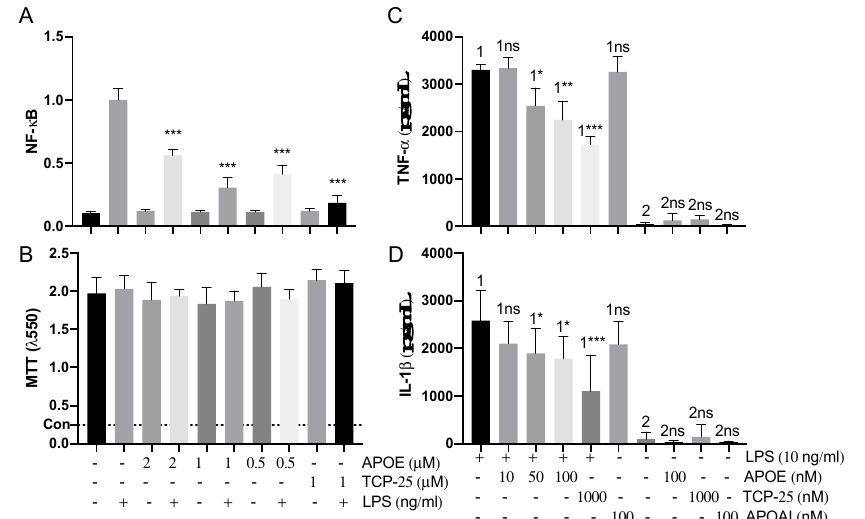
Figure 7. Anti-endotoxic effect of APOE in vitro. ( A ) THP-1-XBlue-CD14 cells were treated with APOE (0.5, 1 and 2 µ M), LPS (10 ng/mL) from E. coli , or a combination of both. APOE yielded a significant reduction of activation of NF- κ B/AP-1. *** p ≤ 0.001. ( B ) MTT viability assay for analysis of toxic effects of APOE on THP-1 cells. The dotted line (con) represents positive control of dead cells. The mean values of five measurements ± their SEM are shown ( n = 5). p values were determined using one-way ANOVA with Dunnett’s multiple comparison test. Cytokine analysis of TNF- α ( C ) and IL-1ß ( D ) the blood collected from healthy donors at 24 h after treatment with 10 ng/mL LPS together with 10–50–100 nM APOE. Untreated blood was used as a baseline control. Blood treated with 10 ng/mL LPS together with 100 nM APOAI or 1000 nM TCP-25 were used for comparison. The mean ± SEM values of four independent experiments performed in duplicate are shown ( n = 4). * = p ≤ 0.05, ** = p ≤ 0.01 and *** = p ≤ 0.001, ns = not significant, determined using two-way ANOVA with Sidak’s multiple comparisons test.